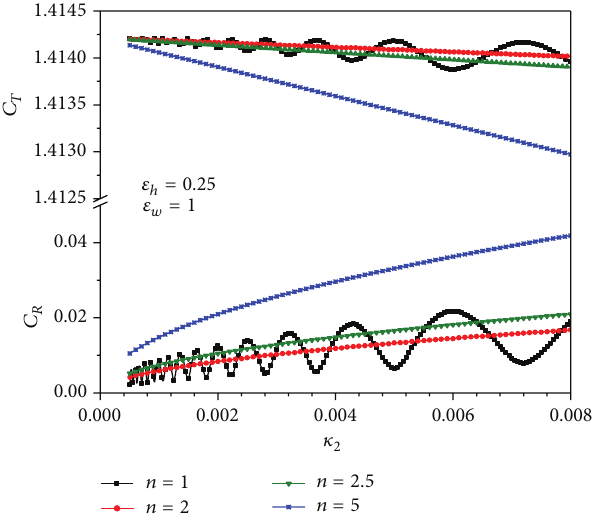
Figure 7: Reflection/transmission coefficients as a function of the kinematical parameter 𝜅 2 with 𝜀 ℎ = 𝜀 𝑤 = 0 . 25 for four values of 𝑚 = 𝑛(= 1 , 2 , 2 . 5 , 5 ) . The depth transitions are given for four values of 𝑛 = ( 1 , 2 , 2 . 5 , 5 ) . It should be noted that the reflection and trans- mission coefficients for a linear bottom transition have an oscillatory behavior with strong oscillations as 𝜅 2 →